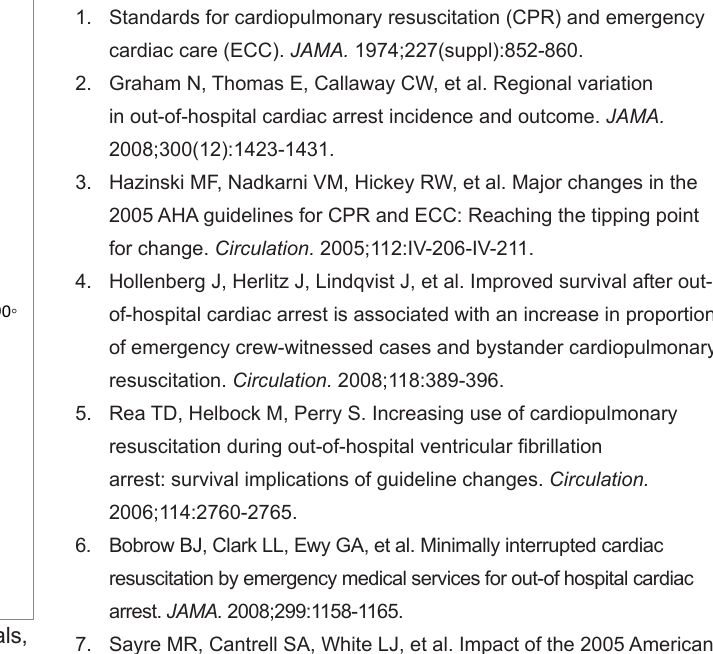
Figure 4. Mean compression depth, with 95% confidence intervals, of subjects who did and did not achieve a 90 ° arm angle.